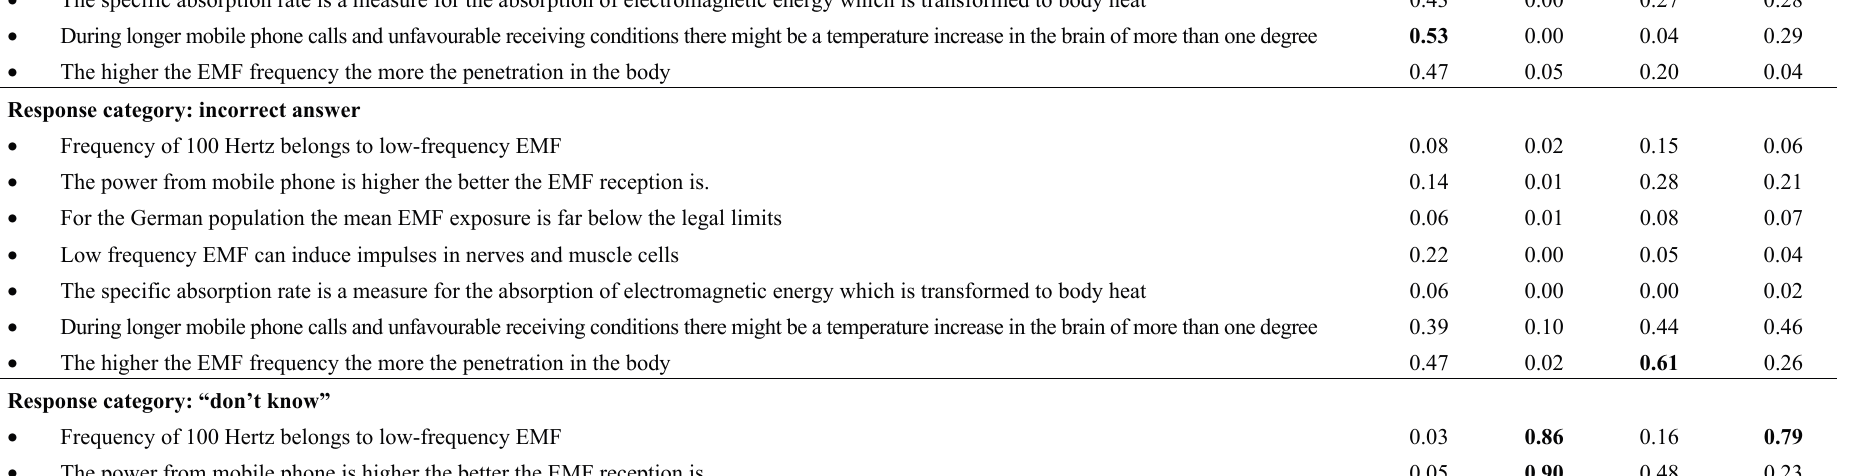
EMF Correct Don’t LF-EMF * Health Knowledge Know 0.43 0.13 0.24